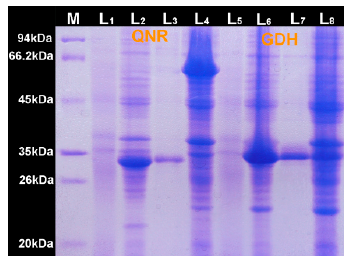
Figure 1. 12% SDS-PAGE gel of protein samples. Lane M, protein molecular weight markers; Lane 1 to Lane 4, Lane 5 to Lane 8 for the E. coli (His-QNR), E. coli (His-GDH) before induction, after induction, the cell lysate supernatant and the cell lysate precipitate, respectively.